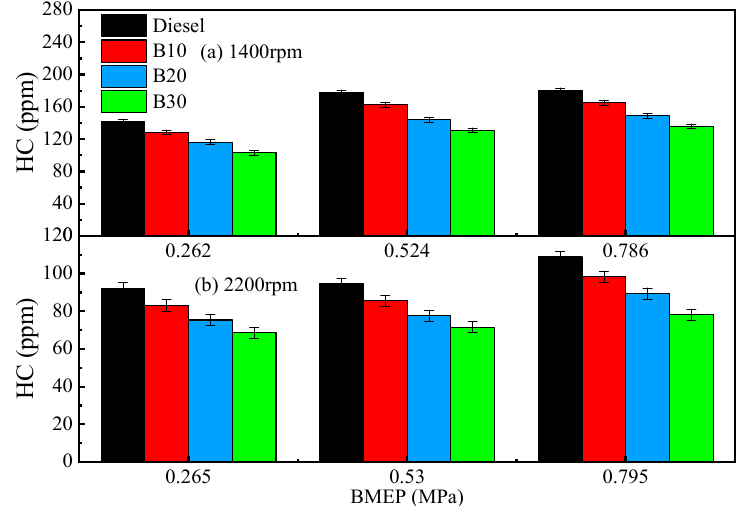
Figure 29. HC emission comparison of biodiesel blends and diesel under different BEMPs [180].( a ) 1400rpm; ( b ) 2200rpm.